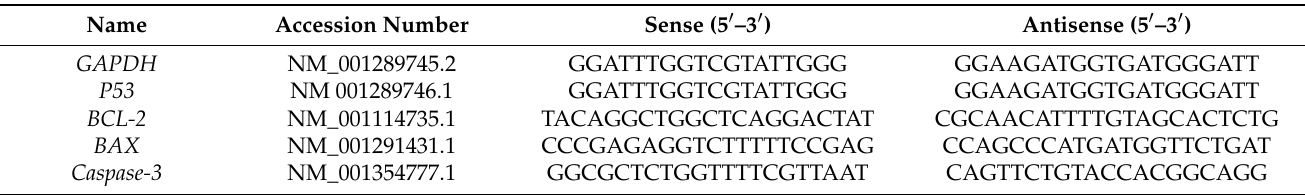
Table 1. Primer sequences of genes analyzed by real-time